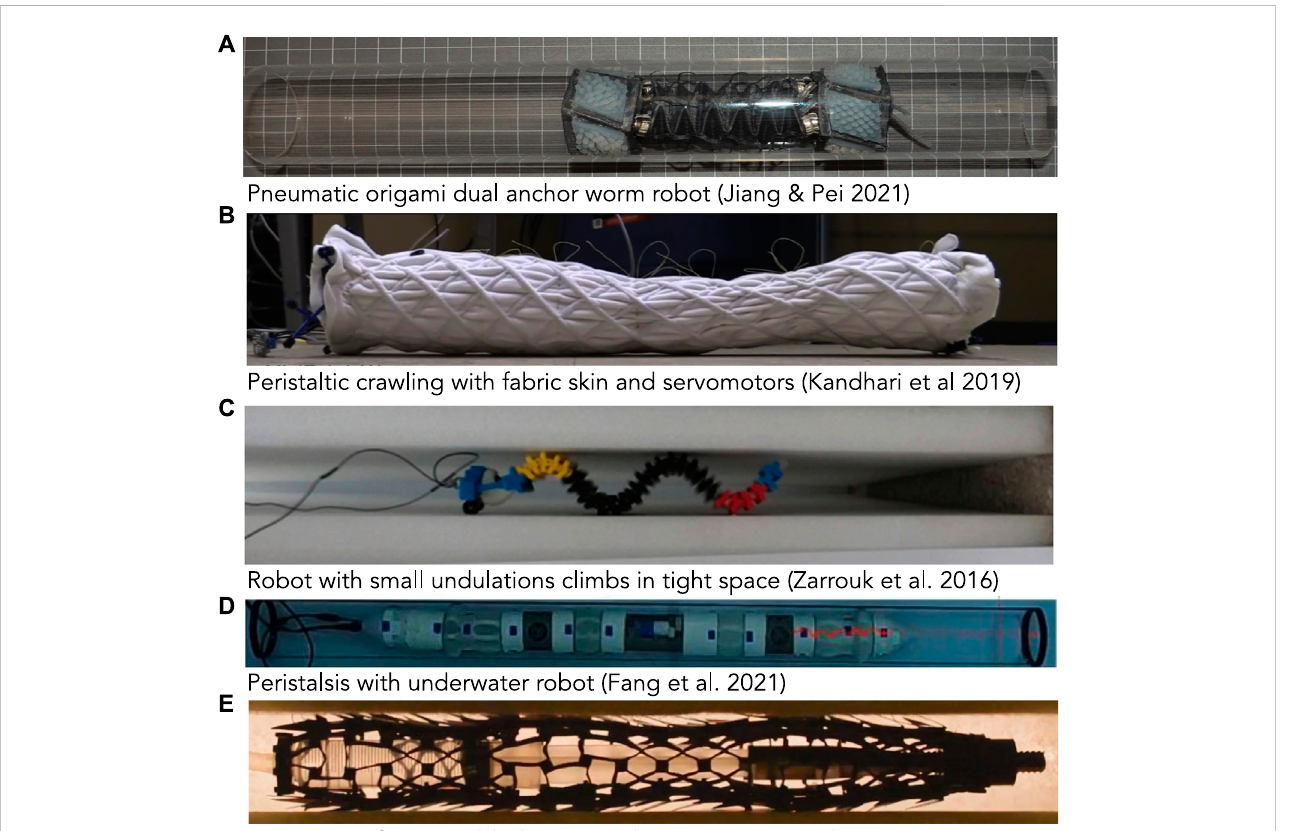
FIGURE 7 Photos of worm-inspired robots. (A) Pneumatic origami, dual-anchor robot (reproduced from Figure 4 of Jiang and Pei (2021) with permission). (B) Peristaltic crawling robot comprising fabric skin over servomotors (Kandhari et al., 2019b). (C) Undulating, worm-inspired robot crawling up between vertical wallswithsmallundulationsactingasanchors(reproducedfromZarrouketal.(2016)withpermission).Thisimagewasrotatedtoalignwithotherimagesinthe fi gure; the robot is moving vertically (toward the left) (D) Peristaltic robot with paired expanding and elongating segments moving through a tube underwater (toward the right) (Fang et al., 2021). (E) Peristaltic robot made from printed metamaterials with chaetae-like extensions added to create anisotropic friction (Dikici et al.,